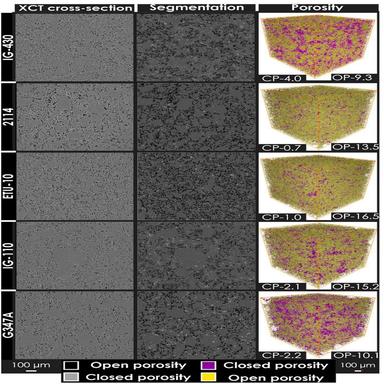
XCT data of super-fine nuclear graphite grades nuclear graphite grades. Reconstructed raw XCT slice, segmented graphite, CP – closed porosity and OP – open porosity. The percentages included in the illustrations provide the content of CP and OP in each grade.